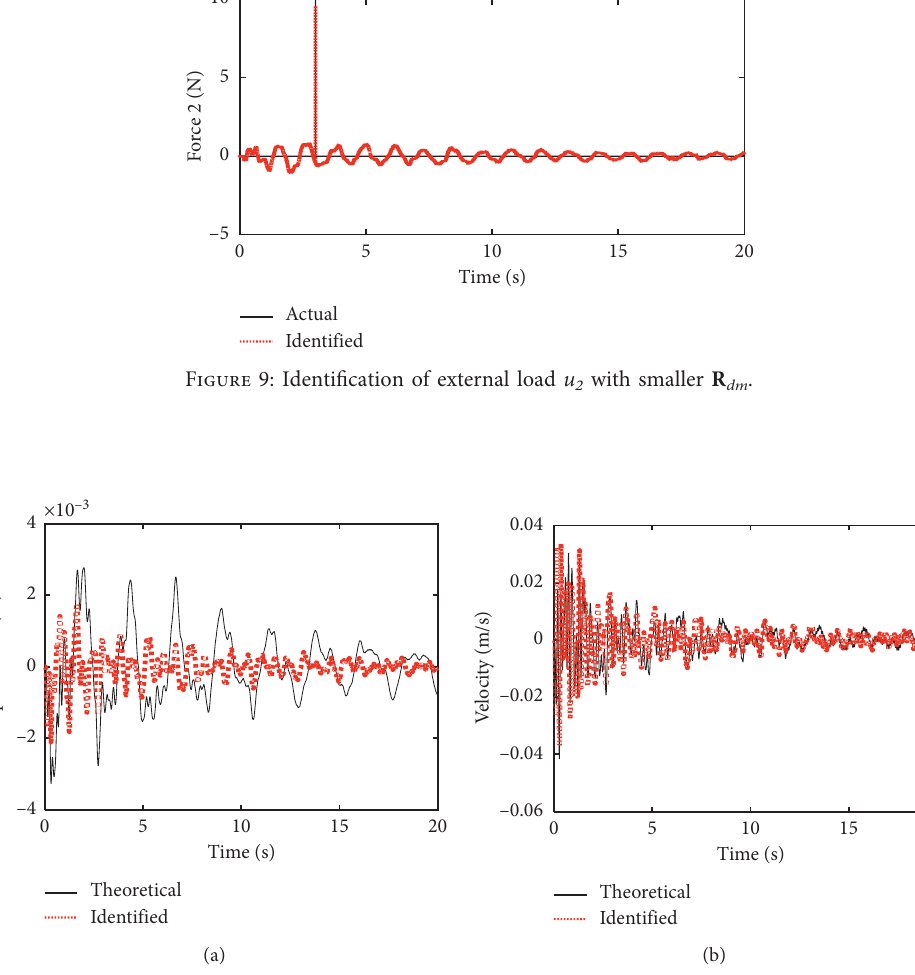
dm . (b) Theoretic and determined vertical velocity at node 7.